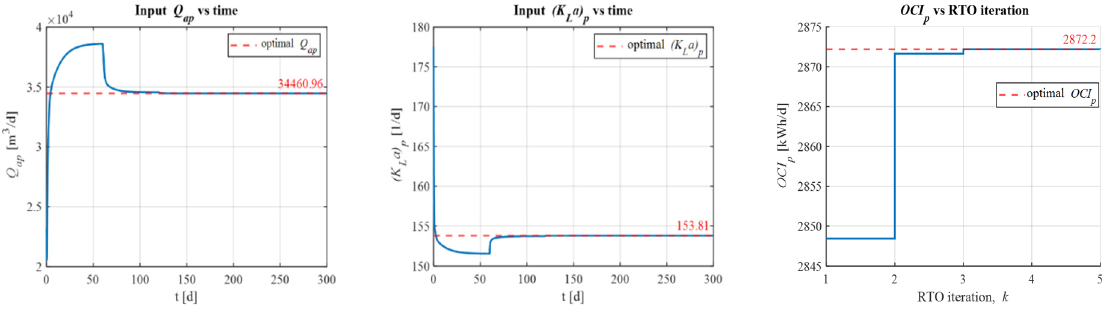
Figure 5. CA results–Plant inputs and overall cost index.